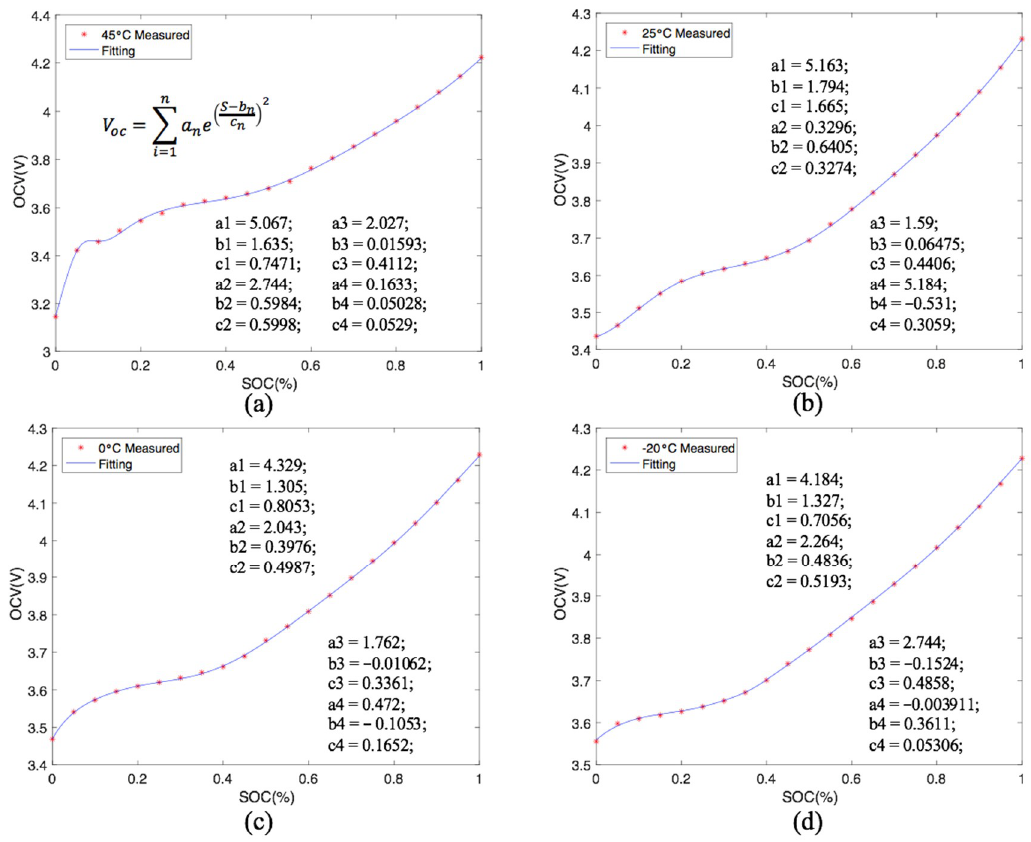
Figure 9. OCV-SOC measured points and Gaussian model fitting curves for ( a ) 45 ◦ C; ( b ) 25 ◦ C; ( c ) 0 ◦ C; Figure 9. OCV‐SOC measured points and Gaussian model fitting curves for ( a ) 45 °C; ( b ) 25 °C; ( c ) 0 ( d ) − 20 ◦ C temperatures. °C; ( d ) −20 °C temperatures.